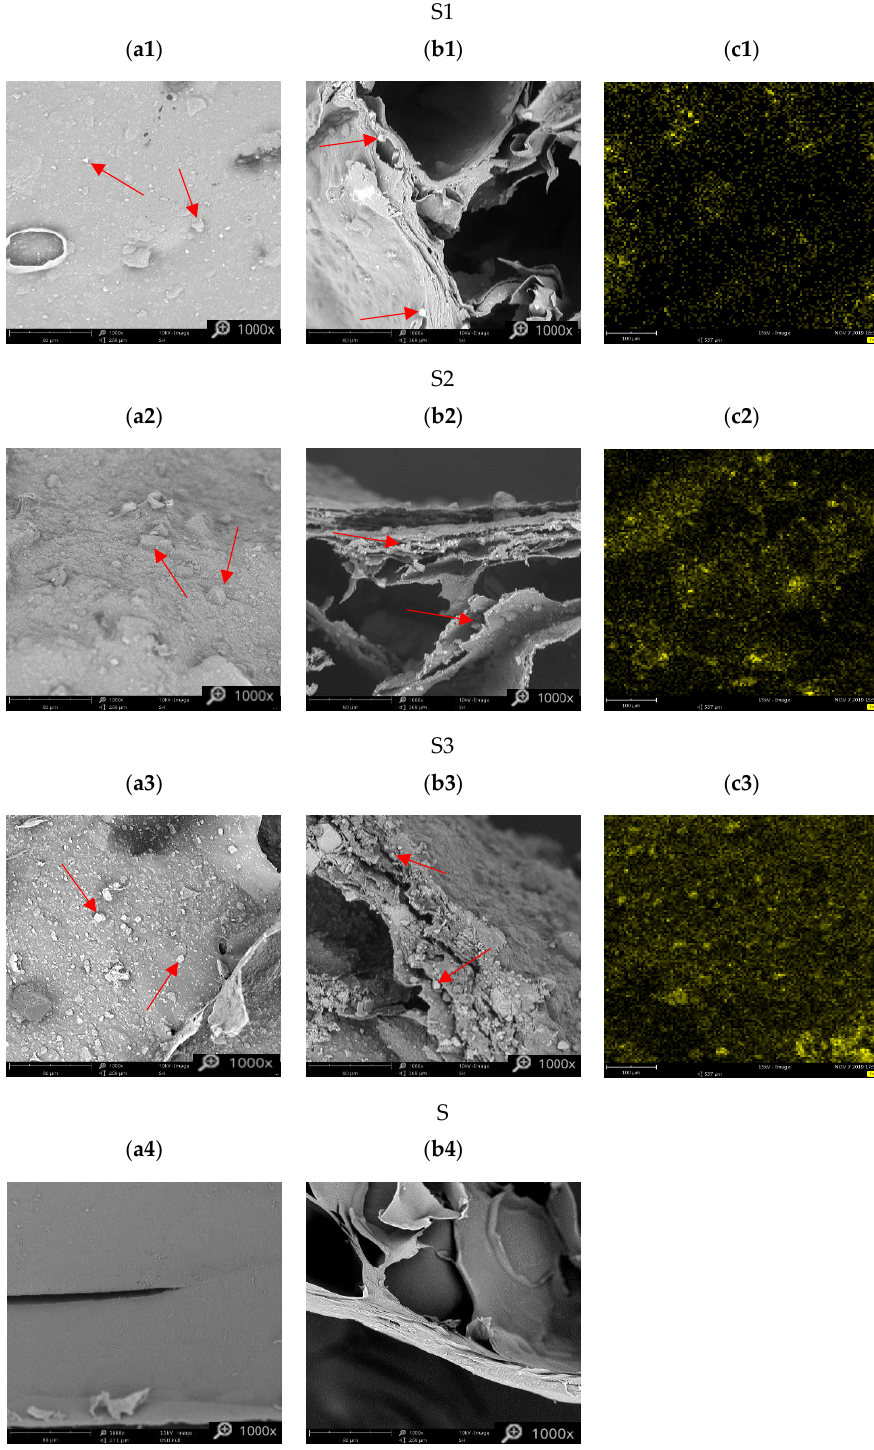
Figure 4. SEM micrographs of outer surface ( a1 – a4 ) (magnification 1000 × ), the cross-section ( b1 – b4 ) (magnification 1000 × ) and the Fe (yellow dots) EDS mapping ( c1 – c3 ) of hybrid sorbents with: 3.6% PB additive (S1), 25.6% PB additive (S2), 43.5% PB additive (S3), and the pectin-only sorbent